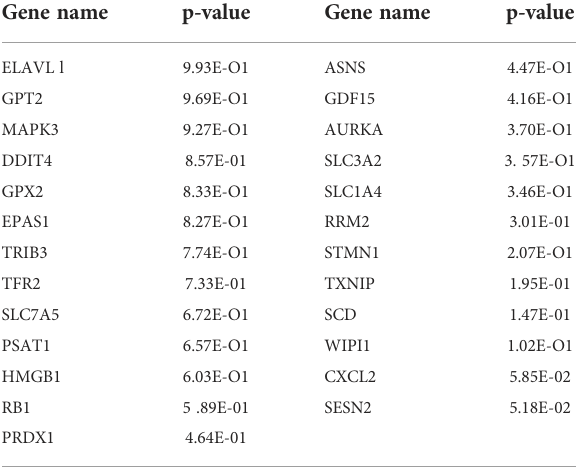
TABLE 2 Name and P-value ranking of the 25 genes that intersect with PPI, WGCNA and ferroptosis